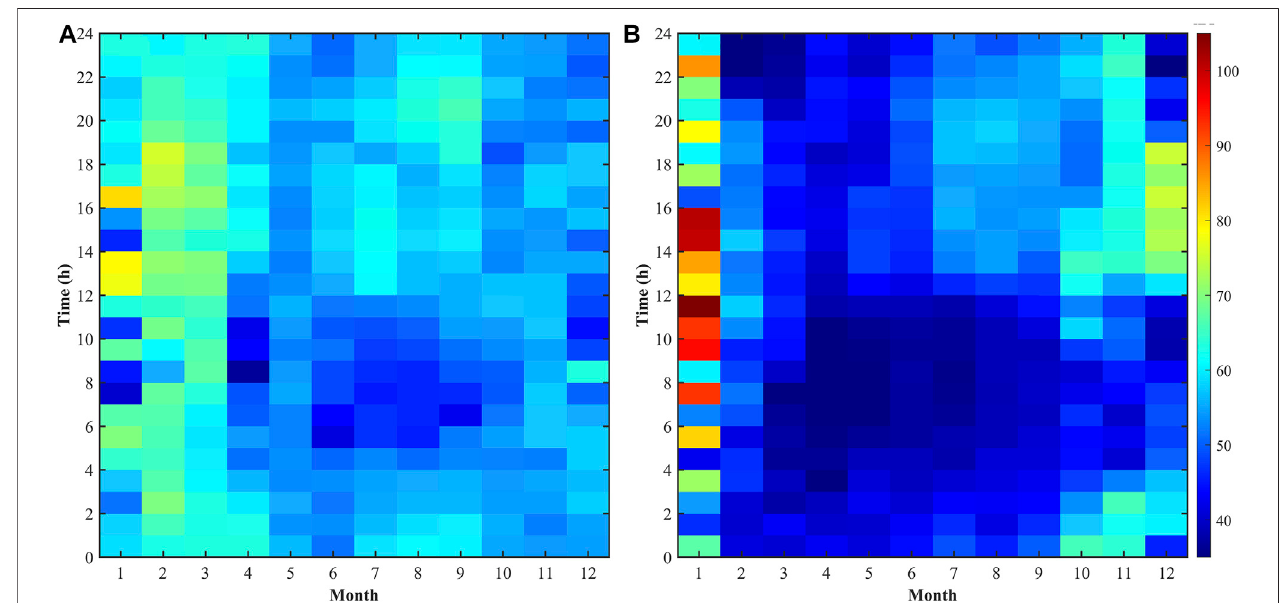
FIGURE 2 | Time distribution diagram of lightning current amplitude (A) Positive fl ashes and (B) Negative fl ashes.